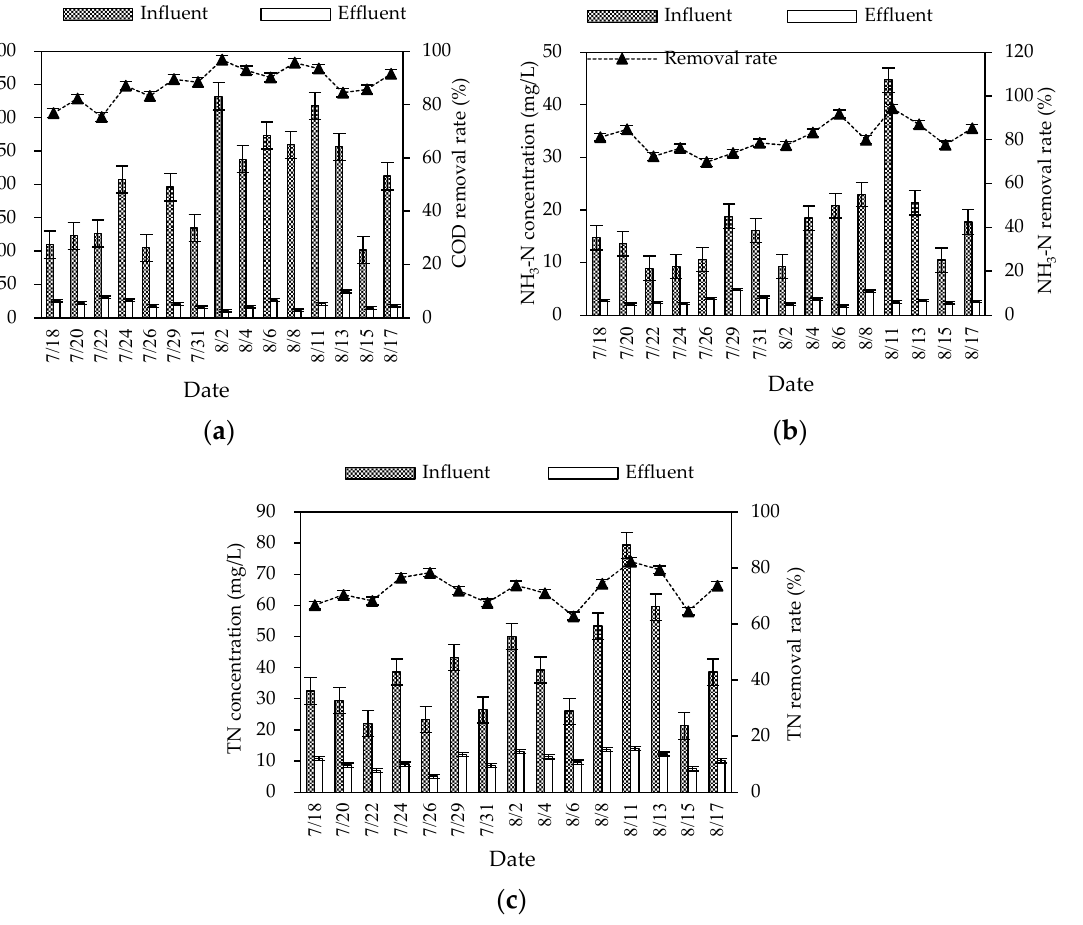
Figure 2. Changes in summer COD ( a ), NH 3 –N ( b ), and TN ( c ) concentrations and removal rates in the combined system.